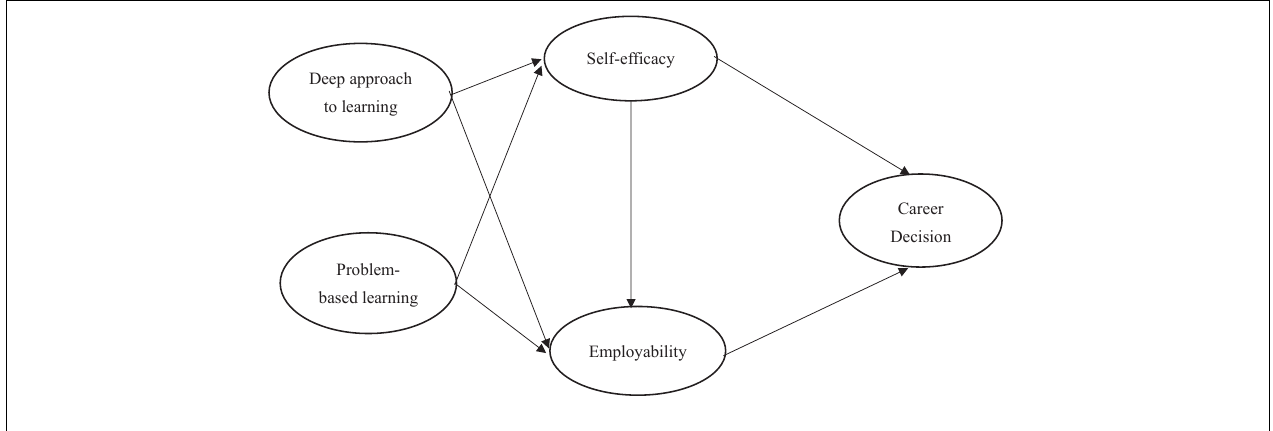
FIGURE 1 | Research